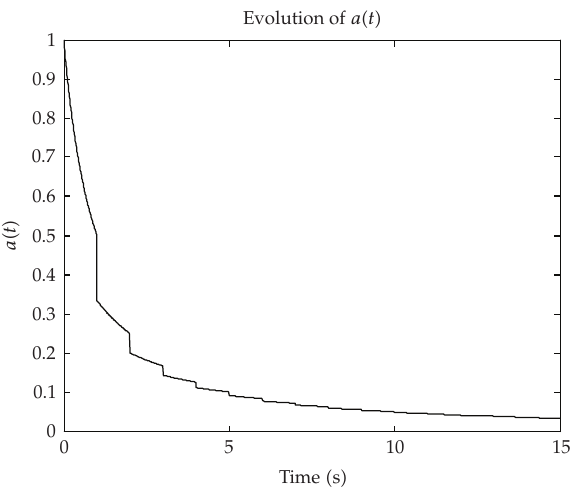
Figure 1: Graphical representation of a (cid:4) t (cid:5) .